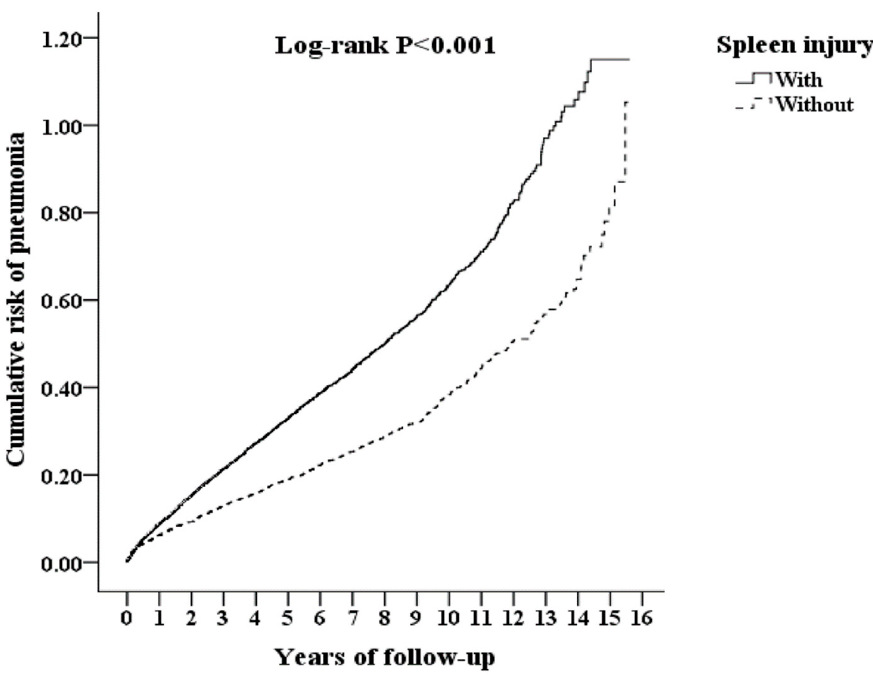
Figure 2. Kaplan–Meier estimate of the cumulative risk of pneumonia among study participants according to baseline spleen injury status.